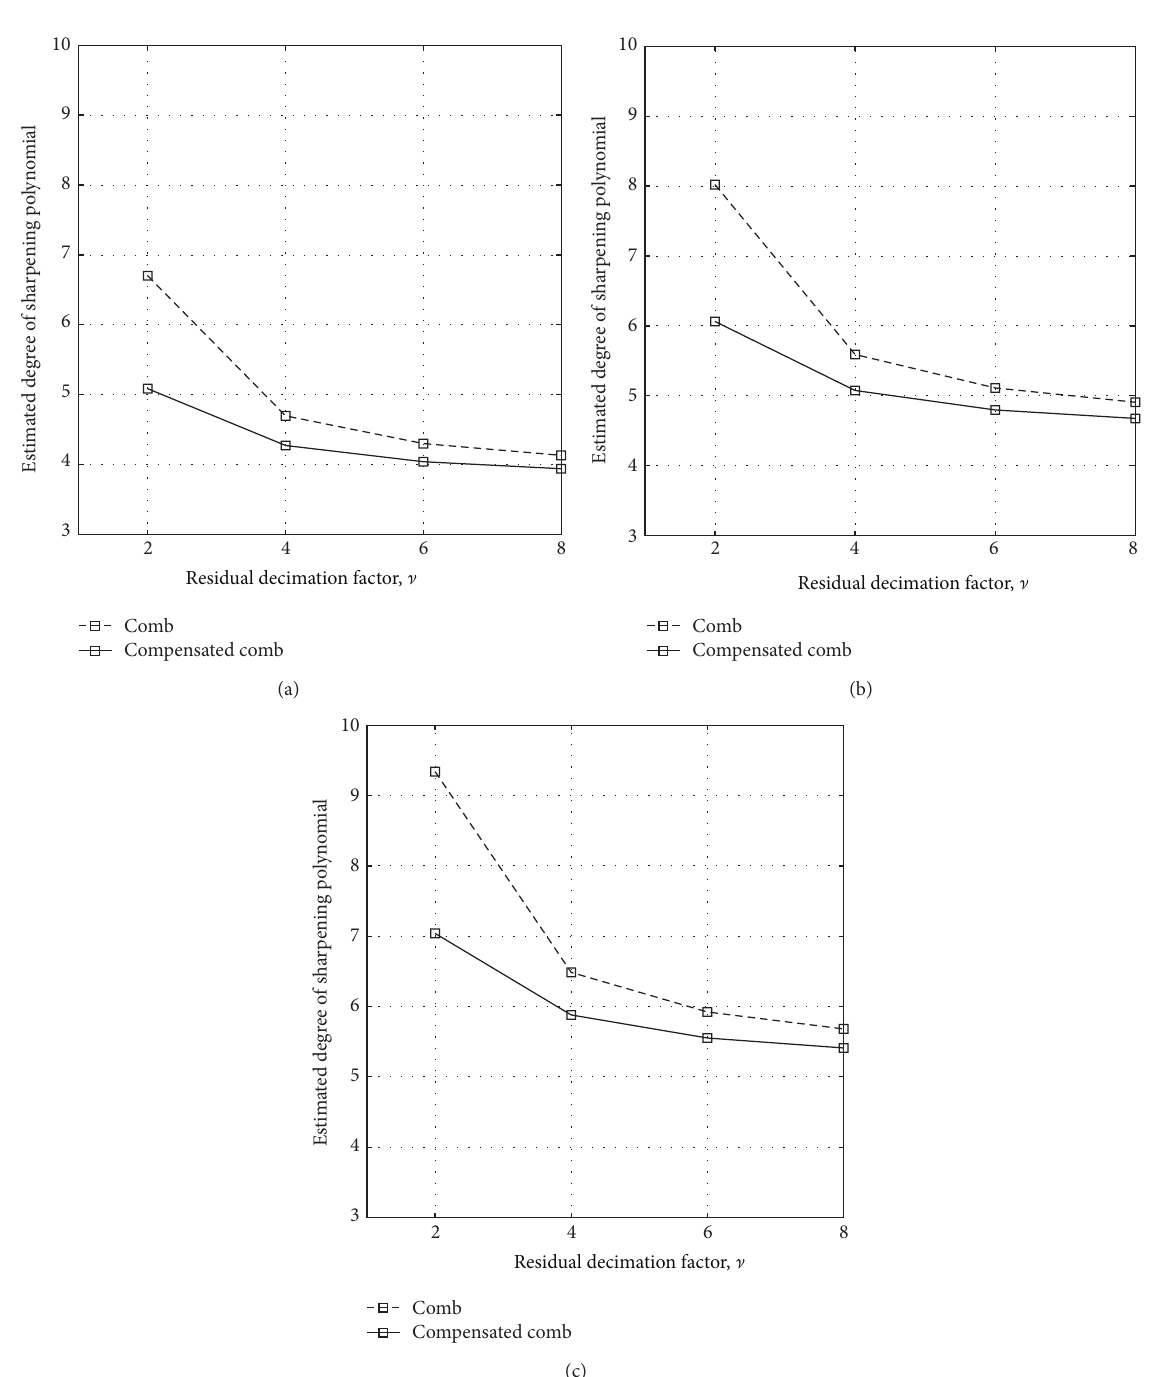
Figure 2: Estimated degree of the sharpening polynomial to sharpen comb filters (dashed line) and compensated comb filters (solid line), with 𝛿 𝑝 = 0.001 and 𝛿 𝑠 = 0.001 (a), 𝛿 𝑠 = 0.0001 (b), and 𝛿 𝑠 = 0.00001 (c).